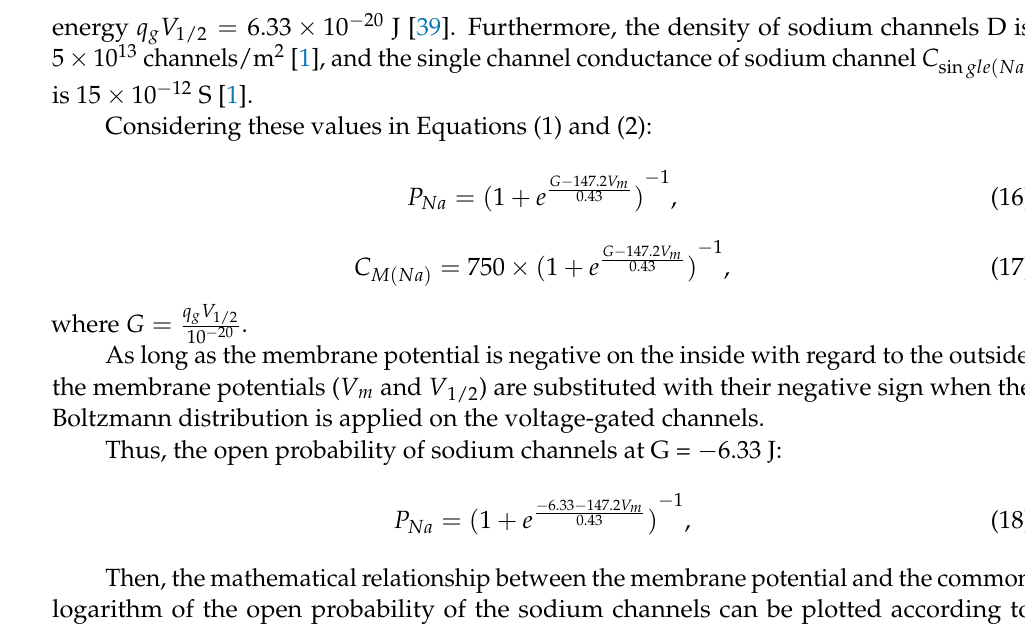
Figure 2. The relationship between gating free energy and the common logarithm of the open probability of the sodium channels at membrane potential − 0.087 V and over gating free energy range from − 12 J to − 5 J. The reference point of membrane potential − 0.087 V will be used throughout the pa- per to carry out the calculations where appropriate. This value of membrane potential represents the resting membrane potential at physiological concentrations and resting leaky conductance values of sodium and potassium ions (See Section 3.5 for values and calculations). The membrane conductance of sodium ions according to the Boltzmann distribution at G = − 6.33 J: